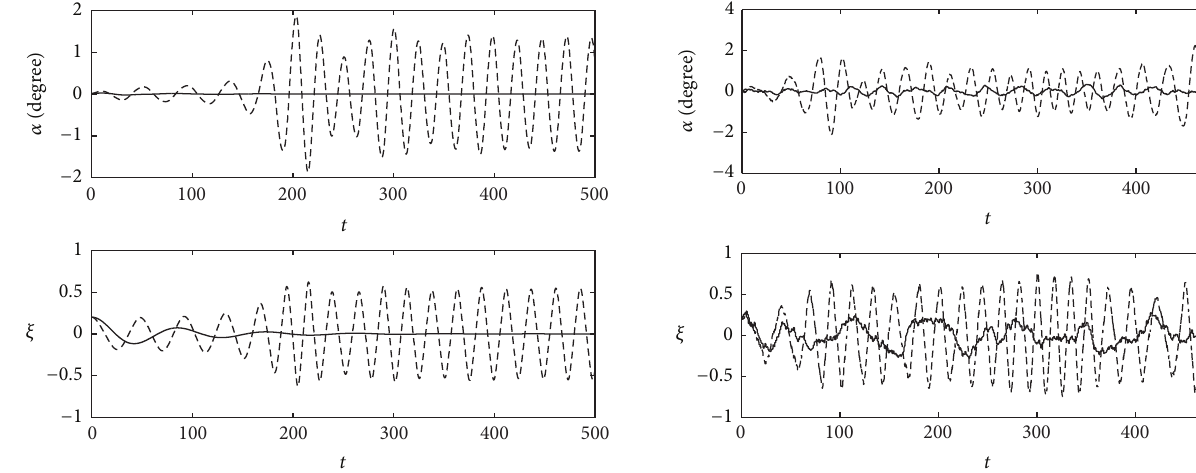
Figure 10: Time histories for system (17) with IC = [1 ∘ ,0,0,0] . Parameters are 𝑈/𝑈 𝑓 = 0.8 and 𝜂 = 8 (solid lines) or 𝜂 = 100 (dashed